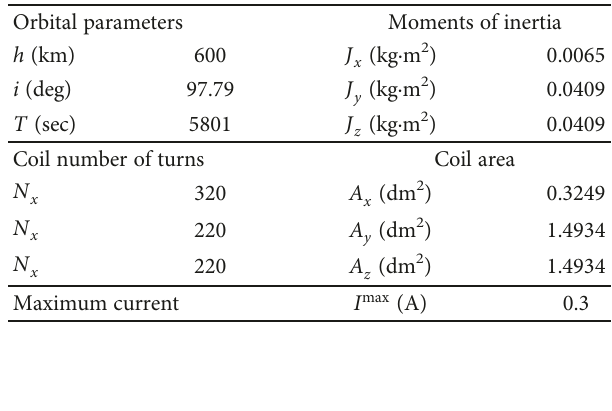
Table 1: Tigrisat parameters.